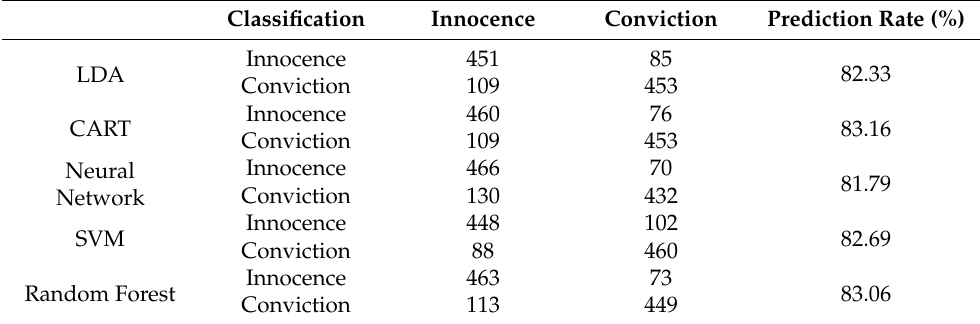
Table 3. Classification for Judicial Decisions.